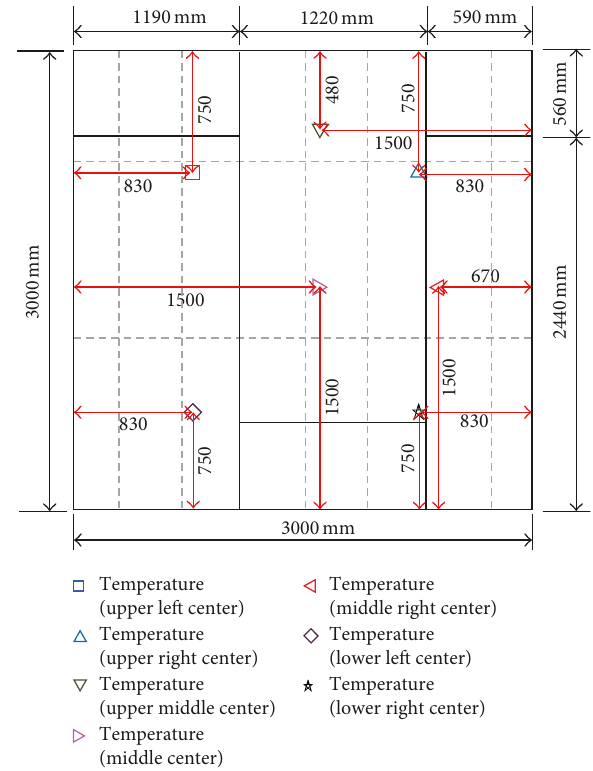
Figure 6: Test 1: the unexposed surface of the specimen and ge- ometry of the